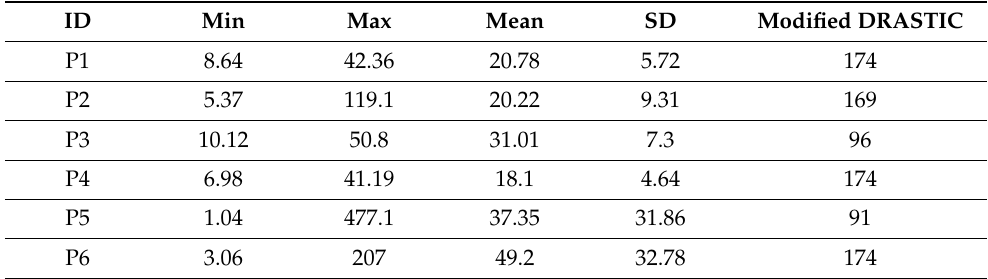
Table 3. Mean, maximum, minimum, standard deviation of resistivity values ( Ω .m) and DRASTIC